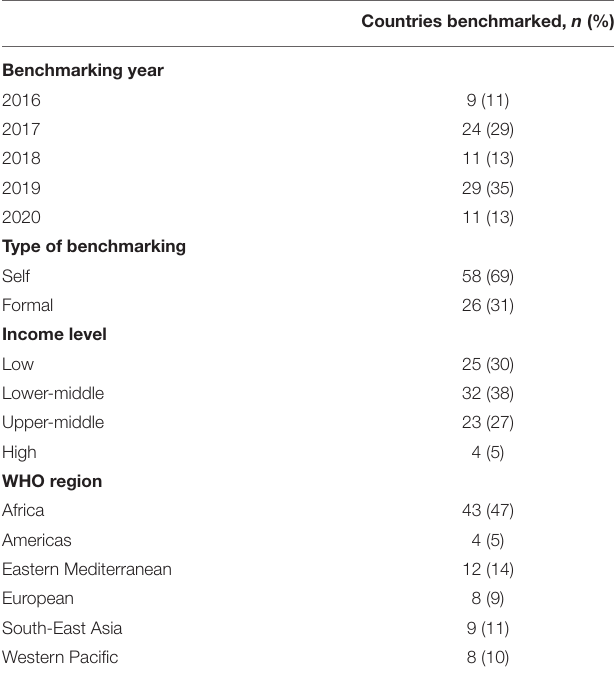
TABLE 3 | Characteristics of 84 member states evaluated using the WHO’s global benchmarking tool (GBT), 2016–2020. Countries benchmarked, n